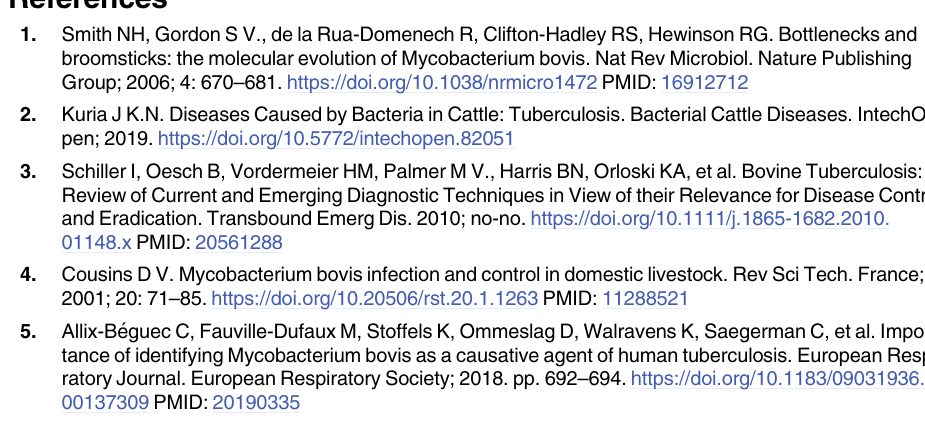
S1 Table. Clinical and field isolates of M . bovis and M . tuberculosis used in this study. S1 Fig. Enzymatic digestion of LAMP